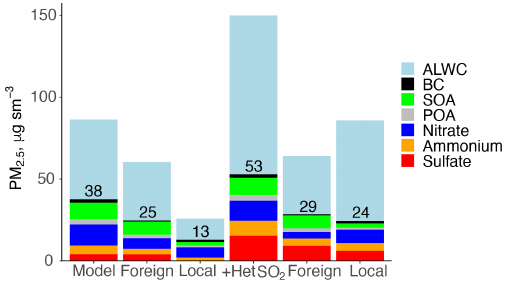
Figure 14. Composition of model PM 2 . 5 during the Transport/Haze period. The foreign and local contributions as well as the model sensitivity test including heterogeneous uptake of SO 2 to aerosol (Het SO 2 ) are calculated as discussed in Sect. 6. The total PM 2 . 5 excluding aerosol liquid water content (ALWC) is given for each